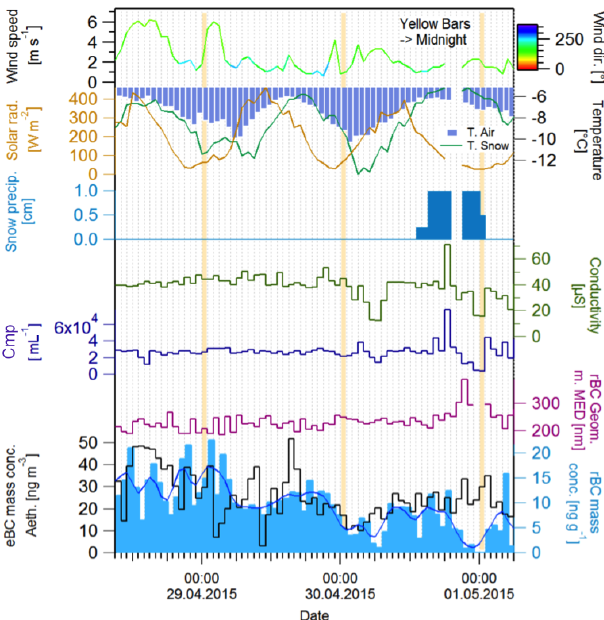
Figure 2. The 85d experiments’ daily snow samples of rBC mass concentration (light blue) and eBC mass concentration in the atmo- sphere (black), geometric mean mass equivalent diameter (purple), number of coarse-mode particles (Cmp – blue) and total conductiv- ity (green). Meteo/snow parameters used in the statistical exercise are wind speed (color coded for wind direction), solar radiation (or- ange line), air and surface snow temperatures (blue bars and green line, respectively), amount of fresh snow (snow precipitation; light blue bars) and the snow accumulation (neg. accumulation; the val- ues where multiplied by − 1 in order to show the similar trend of the snow lost and of the air/snow temperature during the melting period at the end of the